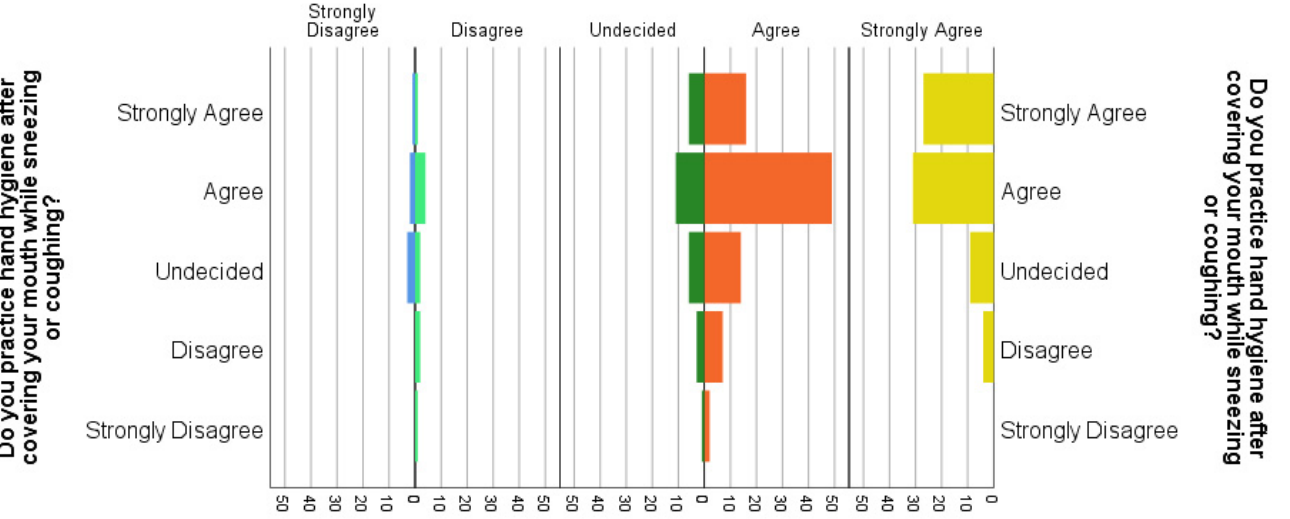
Figure 2. Subjects Pyramid Count “Do you practice hand hygiene after covering your mouth while sneezing or coughing?” by “Do you consider that people diagnosed with respiratory infections must wear a mask?” The colors code is: Blue – Strongly Disagree; Light green – Disagree; Dark green – undecided; Orange - Agree, Yellow - Strongly Agree.